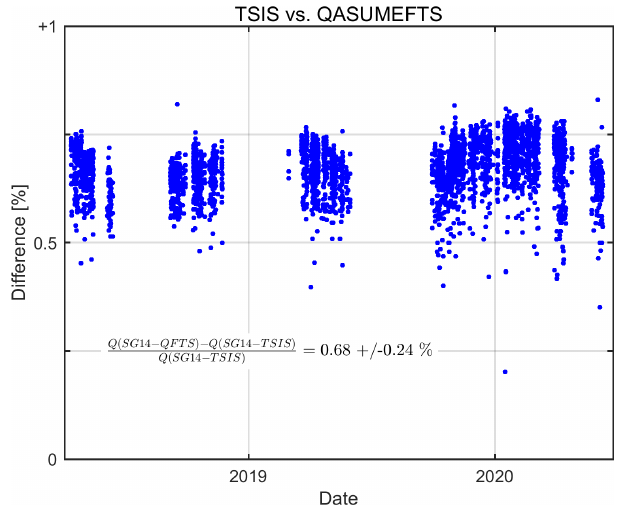
Figure 3. Differences between TSIS extraterrestrial spectrum and QASUMEFTS with SG14 cross section displaying the uncertainty originating from the selection of the solar spectrum.